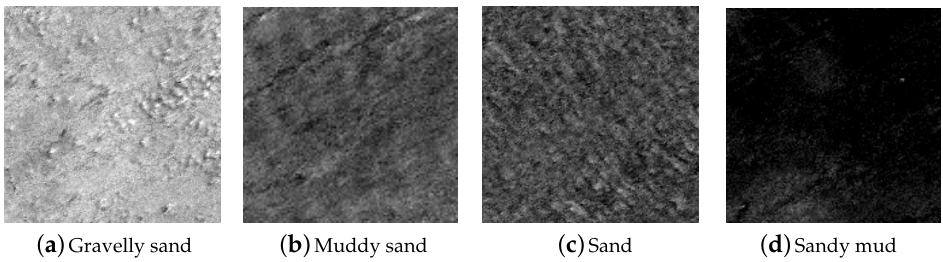
Figure 6. Identified backscatter blocks of four sediment